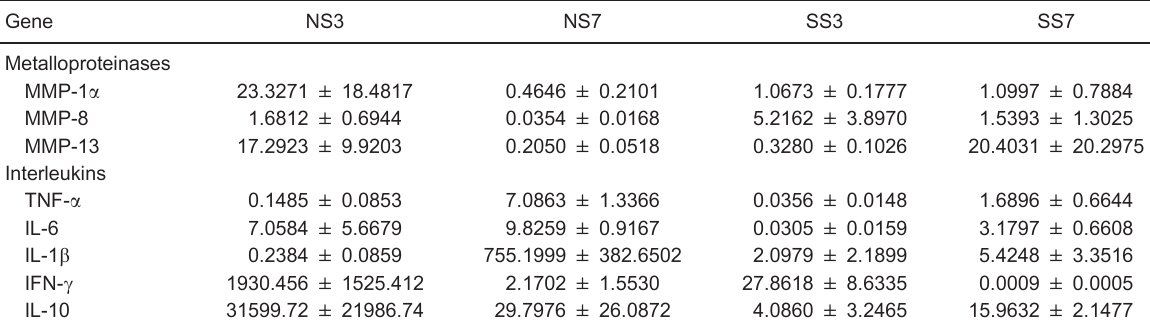
Table 2. Fold-change expression of metalloproteinases and interleukins assessed in septic and non-septic rats.